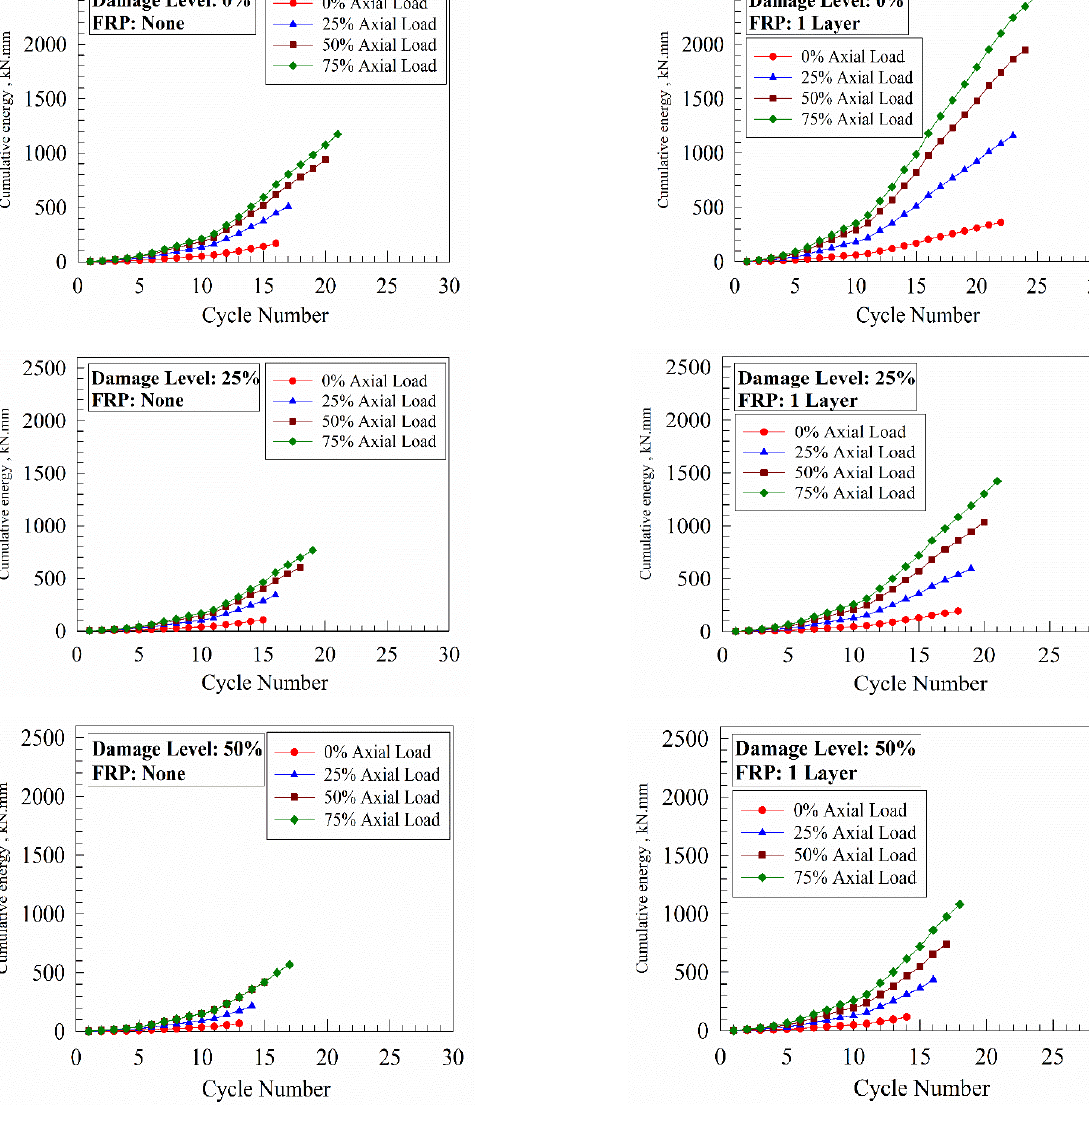
Figure 14. Energy dissipation